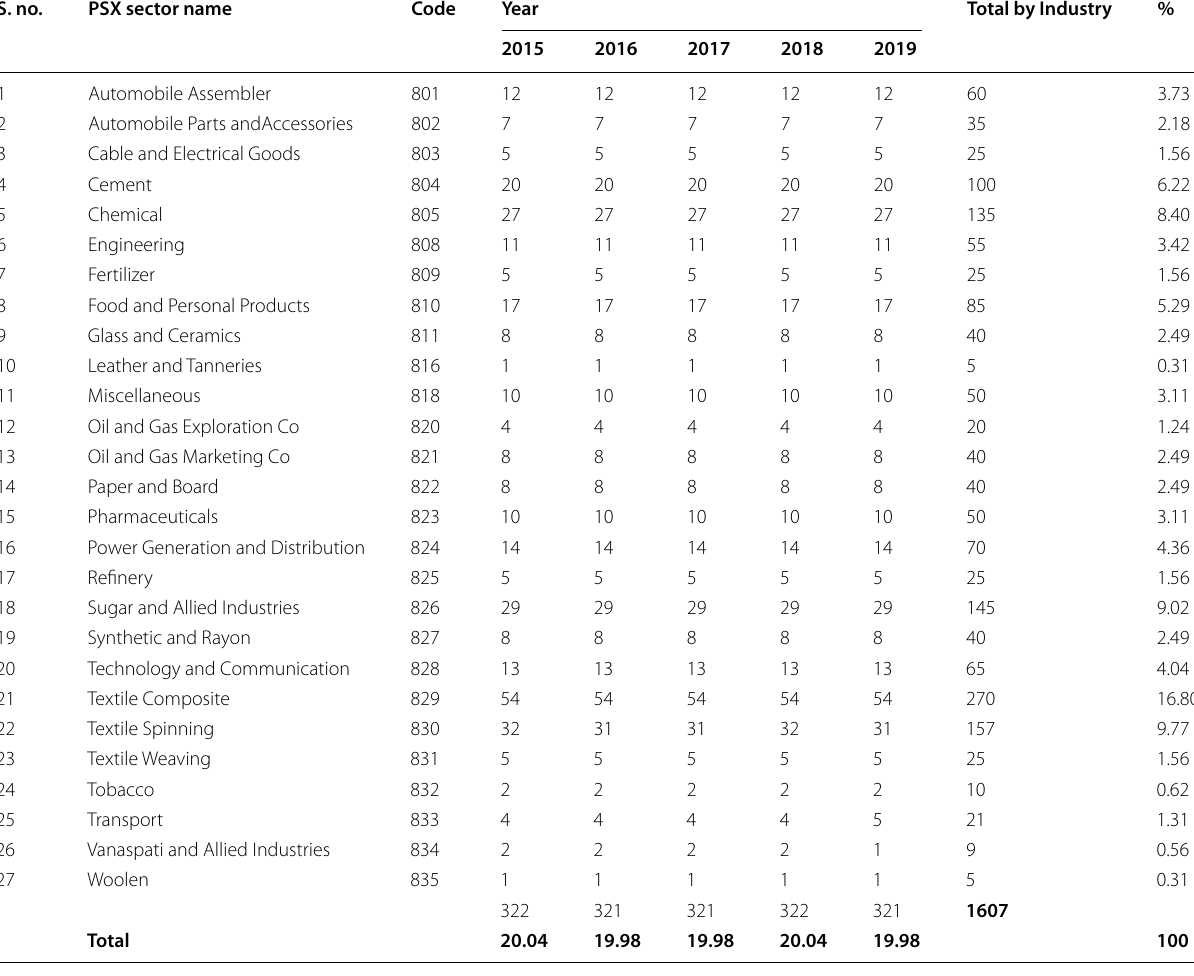
Table 2 Sample distribution by year and industry S.